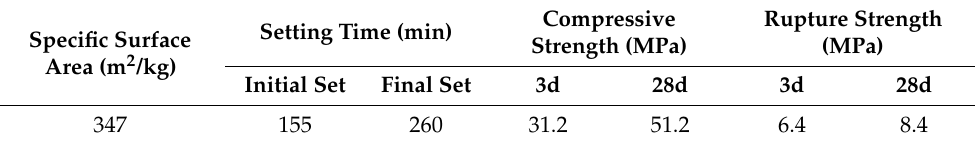
Table 4. The technical specifications of the cement.